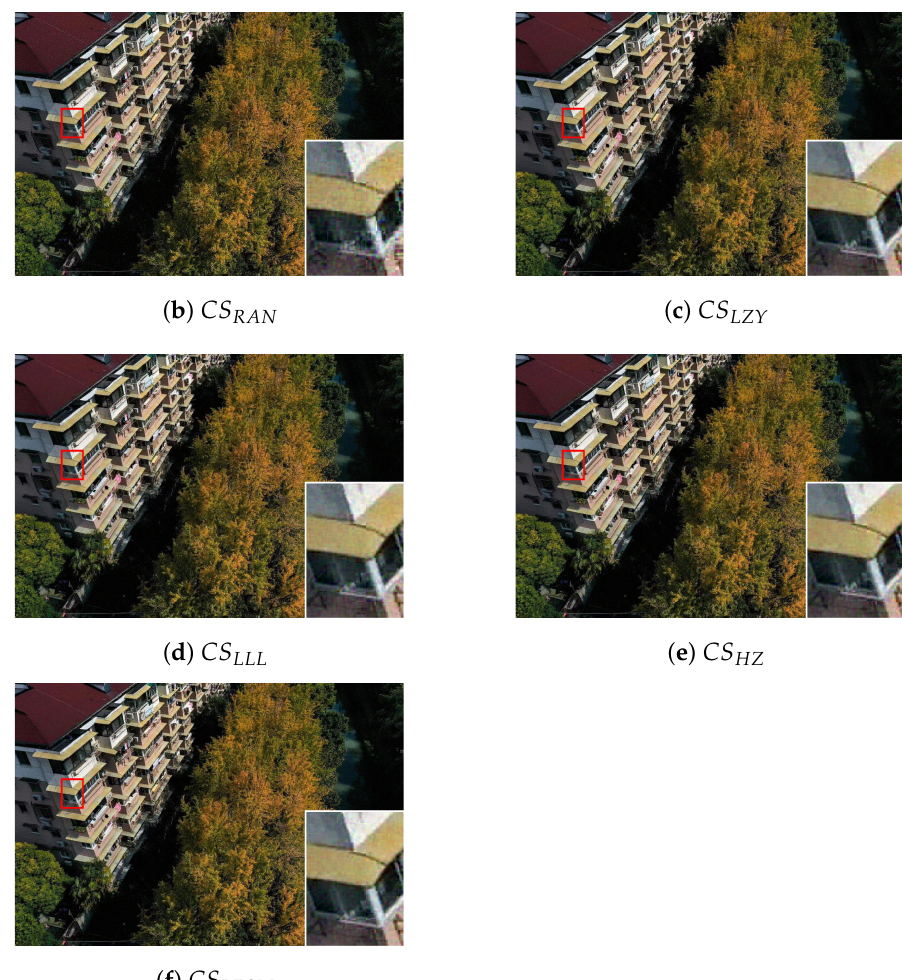
Figure 6. Recovery results for the UAV image "autumn" taken by ourselves with noise ( SNR = 10 dB). ( a ) is the original image, ( a1 ) is the image with noise, ( b ) is the CS RAN algorithm, ( c ) is the CS LZY algorithm, ( d ) is the CS LLL algorithm, ( e ) is the CS HZ algorithm, and ( f ) is the CS LESM algorithm.